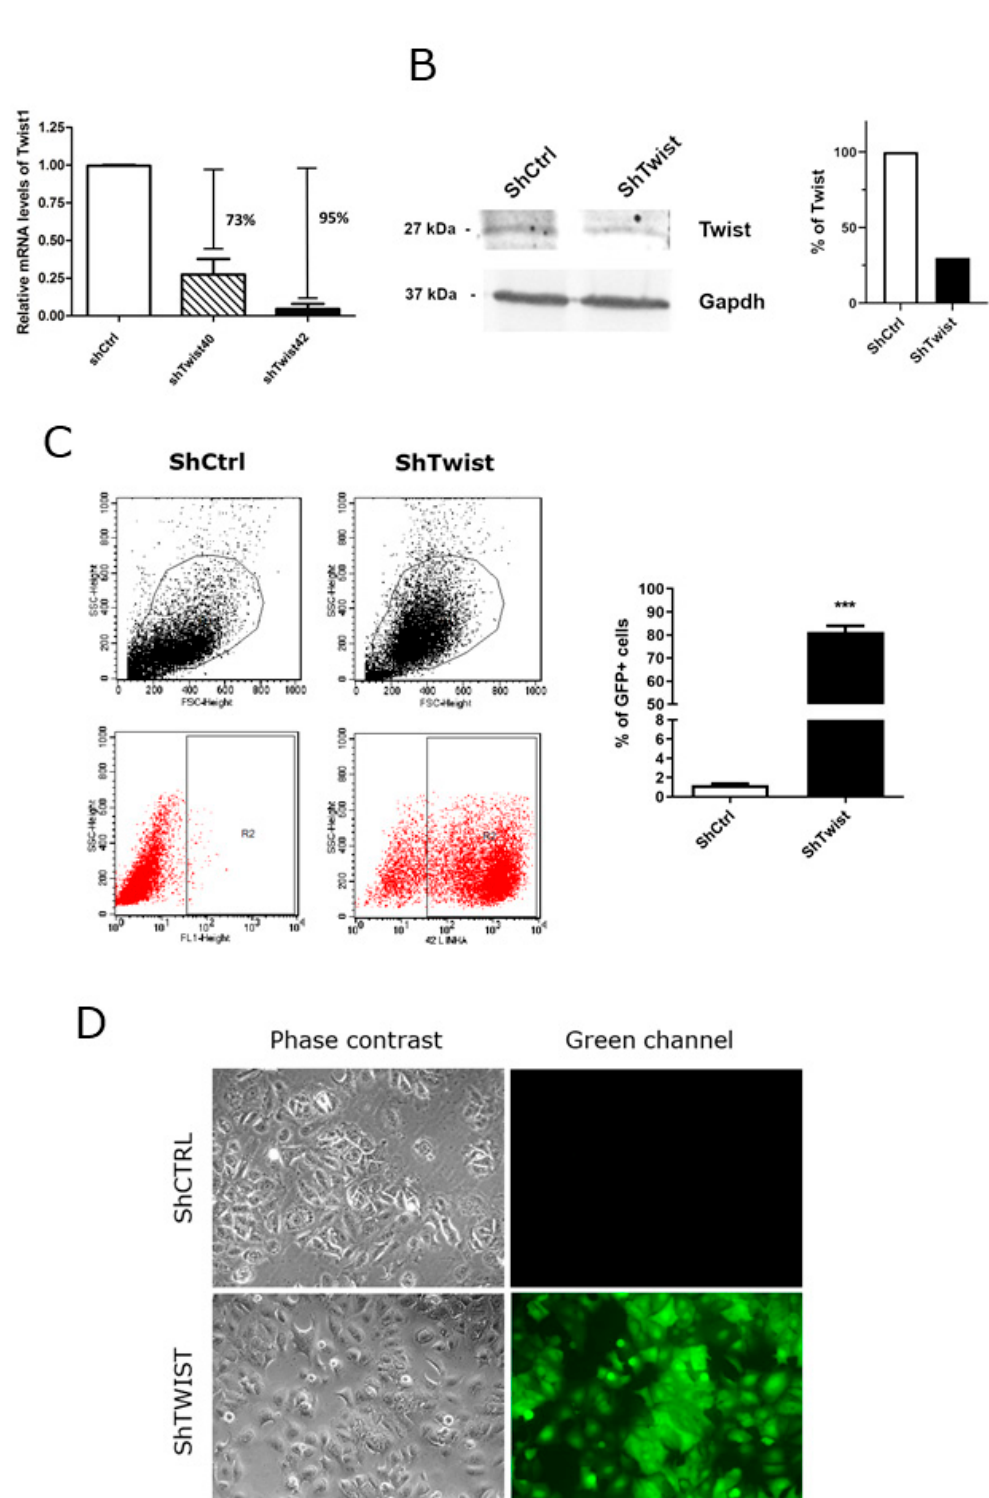
Figure 3. TWIST1 knockdown in HCC-1954 HER2+ BC cells. TWIST1 ( A ) mRNA and ( B ) protein levels in response to gene silencing. GAPDH was used as a loading control. Densitometric analysis was done using ImageJ software version 1.53k ( C ) Flow cytometry comparing ShCTRL and ShTWIST cells. The bar graph represents the percentage of GFP positivity. ( D ) Phase-contrast and fluorescence microscopy of ShCTRL and ShTWIST. Magnification is 200 × . ShCTRL = negative silencing control; ShTWIST40 and ShTWIST42 are two silenced clones obtained experimentally. Data are shown as the mean ( ± SD). *** p < 0.001.